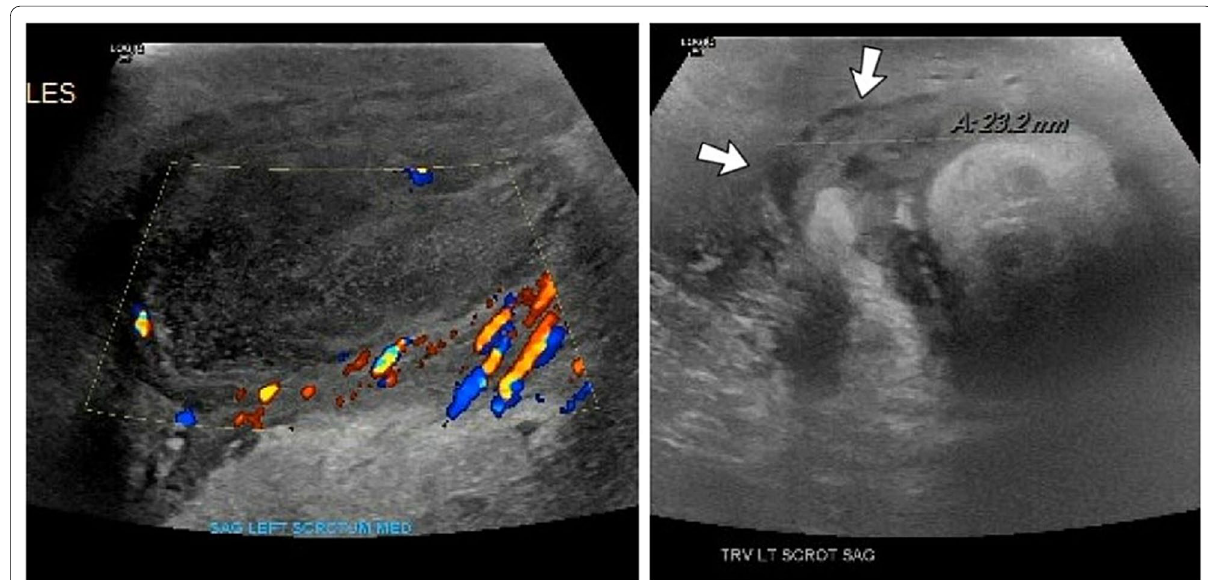
Fig. 2 Sagittal view (left) and transverse view (right) of left scrotal ultrasound showing mild to moderate degree of bilateral, left-sided scrotal wall edematous changes with increased color Doppler flow (left) associated with an ill-defined fluid collection (right with arrows) developing within the left-sided scrotal wall outside the tunica vaginalis. Transverse diameter measured approximately 2.3 cm